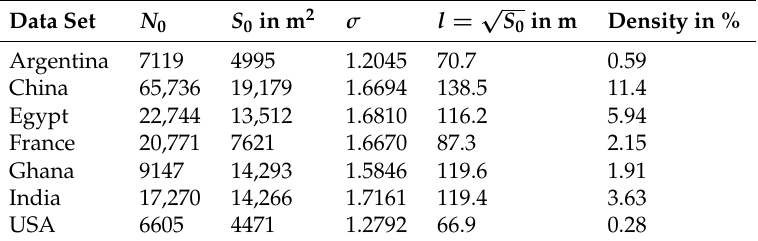
Figure 7. Box plot showing the size distribution of settlement objects in all seven data sets. The arithmetic mean is marked with a red star for each data set. Table 1. Table containing the number N 0 of objects in every data set, and the geometric mean S 0 of the objects’ area. The data sets’ average characteristic size is S 0 = 0.0112 ± 0.0051km 2 . All values are defined as in